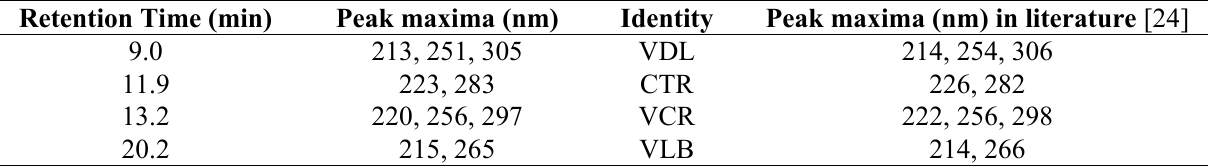
Table 2. UV absorption and identity of peaks in the